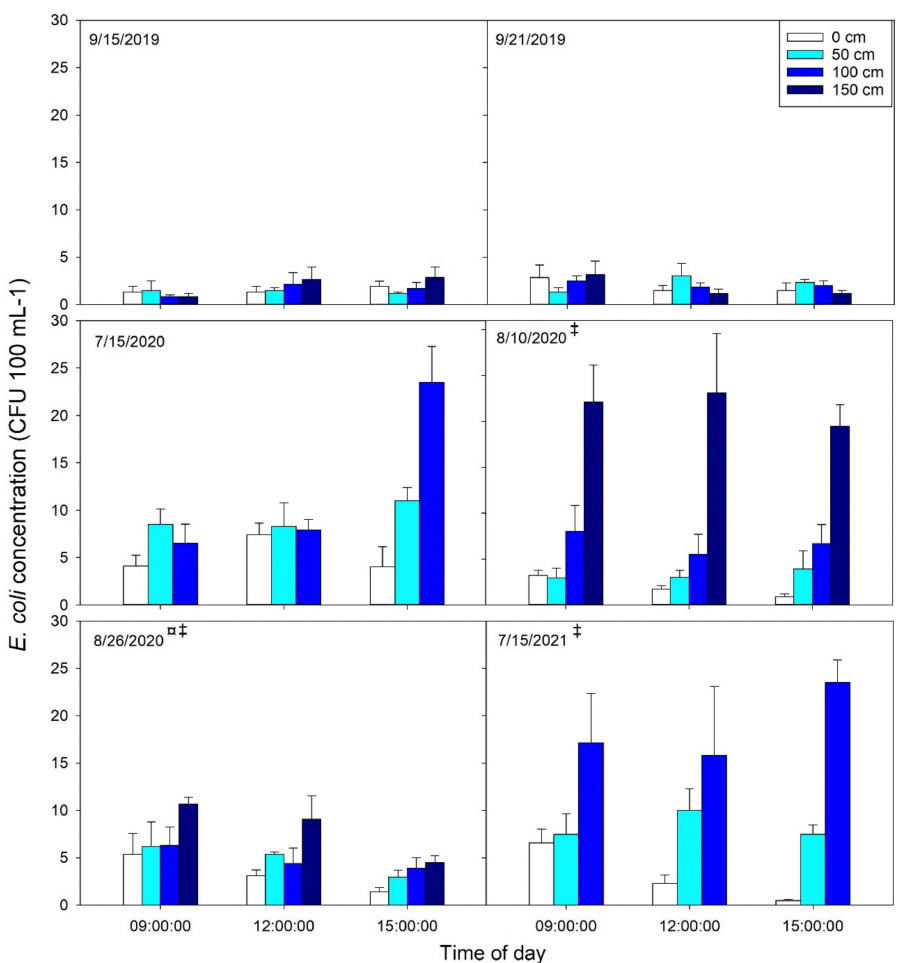
Figure 2. Concentrations of E. coli measured at Pond 2 during the observation dates. Error bars show the standard error of the mean. Dates followed by the symbols ¤ and ‡ indicate statistical significance of the time of day and/or sampling depth, respectively, as a factor as determined by the two-way